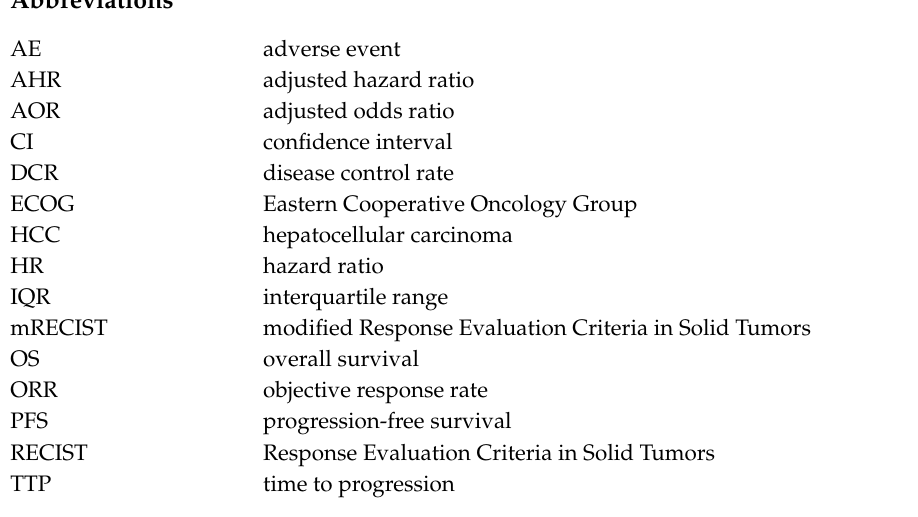
Table S1: Univariate and multivariable analyses for overall survival of the study population, Table S2: Univariate and multivariable analyses for progression-free survival of the study population, Table S3: Univariate and multivariable analyses for overall survival of Child-Pugh B patients, Table S4: Univariate and multivariable analyses for progression-free survival of Child-Pugh B patients, Table S5: Predictive factors for disease control in Child-Pugh B